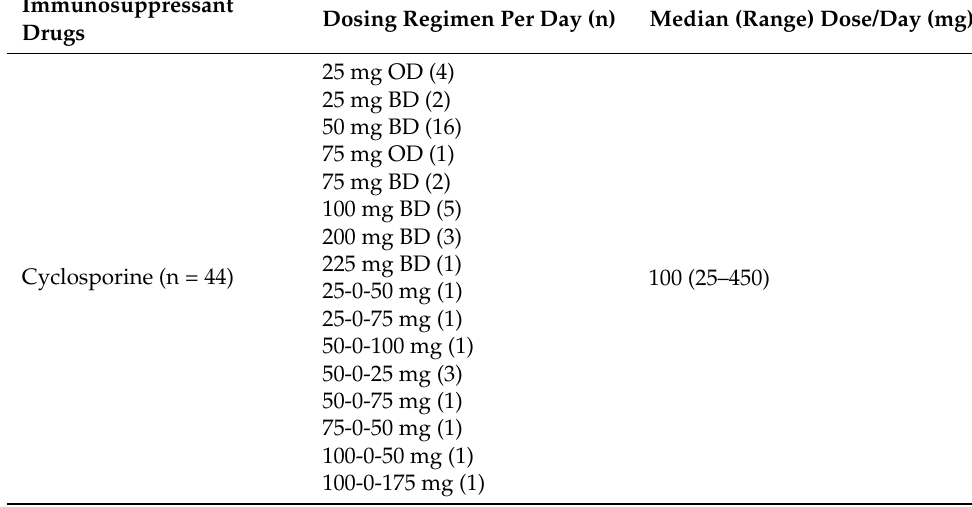
Table 2. Dosing regimen of immunosuppressives in the study participants (N =